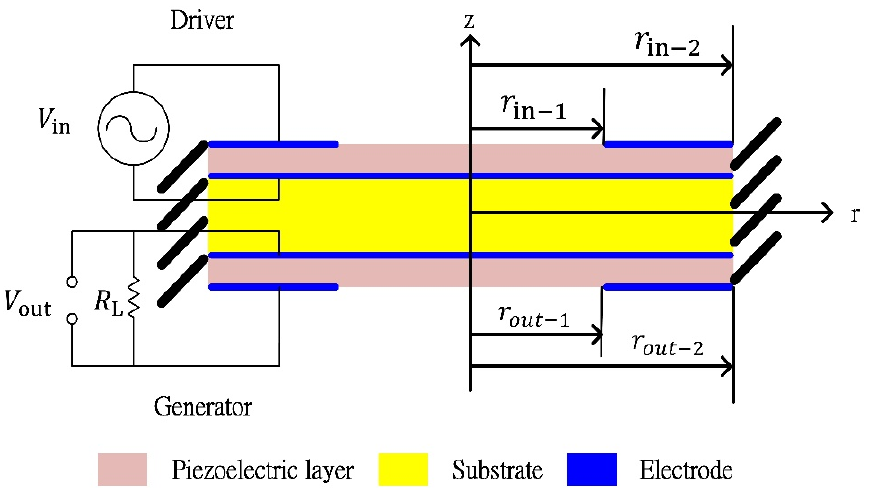
Figure 1. Clamped-edge bimorph disk-type piezoelectric transformer.